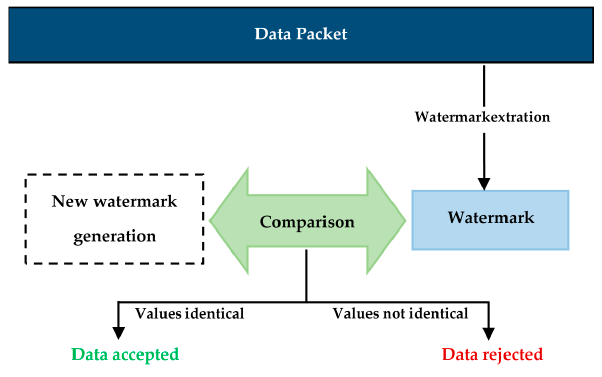
Figure 7. SDAWextraction and verification (the sensor nodes level).